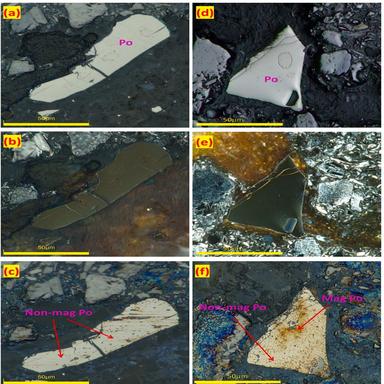
Photomicrographs of the flotation concentrate sample containing pyrrhotite. (a) and (d) depict pyrrhotite grains surrounded by chalcopyrite, gold and nonsulfide minerals like quartz. (b) and (e) exhibit the observed structures of the same grains in (a) and (d) under the polarization microscope. (c) and (f) panels show the effect of the magnetic colloid solution on the surface texture of the examined pyrrhotite grains.